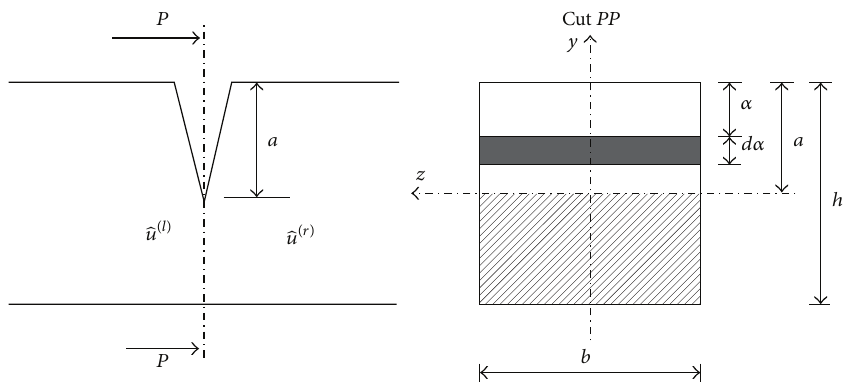
Figure 5: Beam cross section at the crack